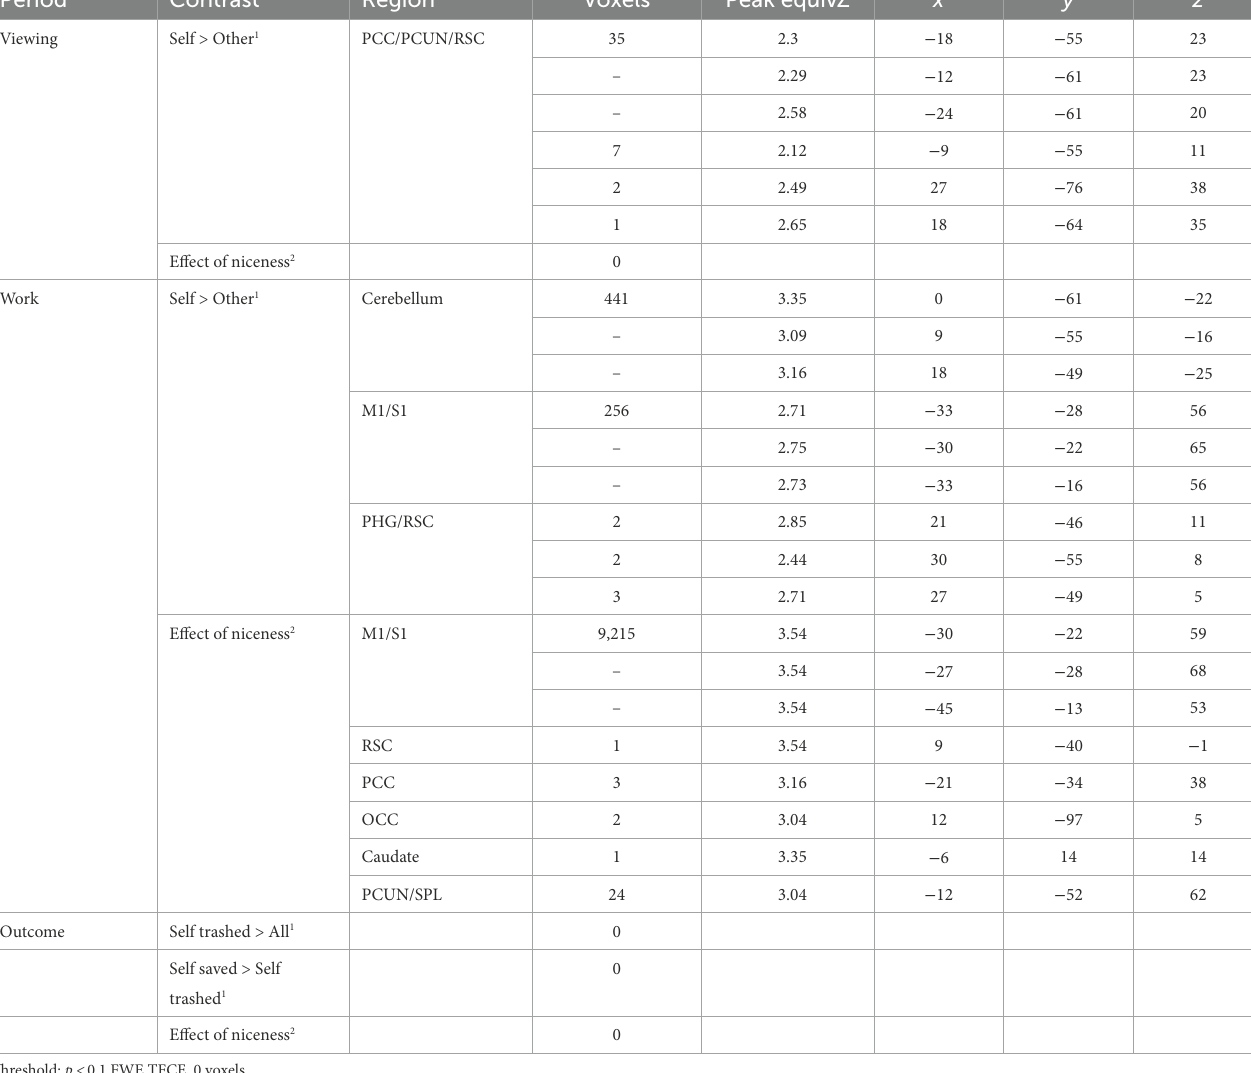
TABLE 3 Whole-Brain contrasts using the 2 × 2 model, per period.